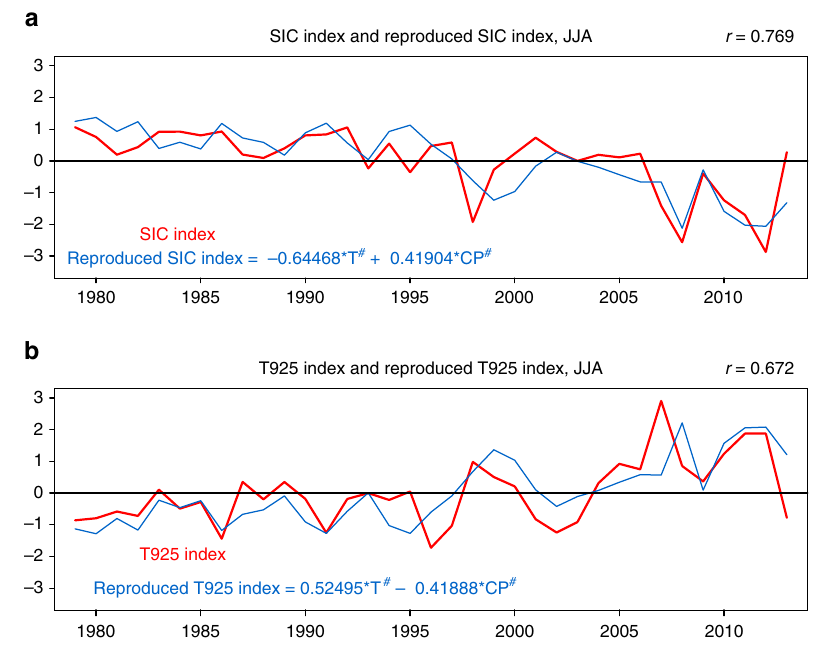
Figure 5 | Original and reproduced time series of SIC-index and T925-index. ( a ) The normalized SIC-index and the reproduced SIC-index, as well as their correlation. ( b ) The normalized T925-index and the reproduced T925-index, as well as their correlation. The reproduced indices are derived from the multiple regression equations as shown in the figure (in the two equations, ‘T # ’ and ‘CP # ’ indicate the normalized trend time series and the normalized and detrended CP index,